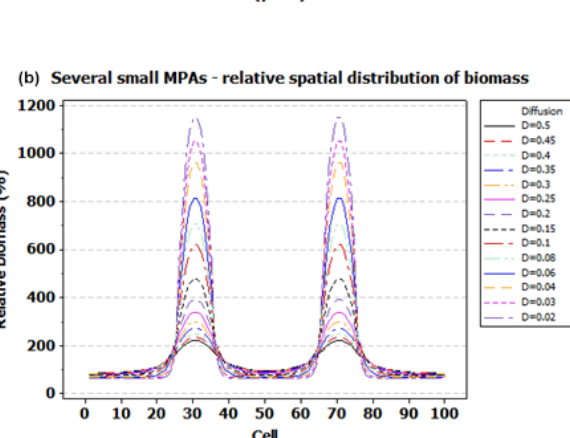
Figure 1. (a) Post-MPA establishment landings over time ( x axis) normalized by the landings before the establishment of an MPA and replicated for a number of species’ dispersal potential (diffusion with values D ). (b) Post-MPA establishment spatial distribution of biomass normalized by the one prior to the MPA establishment. All results are referring to outputs at the end of simulation period (10th year). All simulation scenarios assume that 20% of the cells are pro- tected with a single MPA. All results presented here (regarding fish biomass and annual catch) were normalized to 100 in the steady- state situation without the MPA in each scenario, thus are unitless numbers.